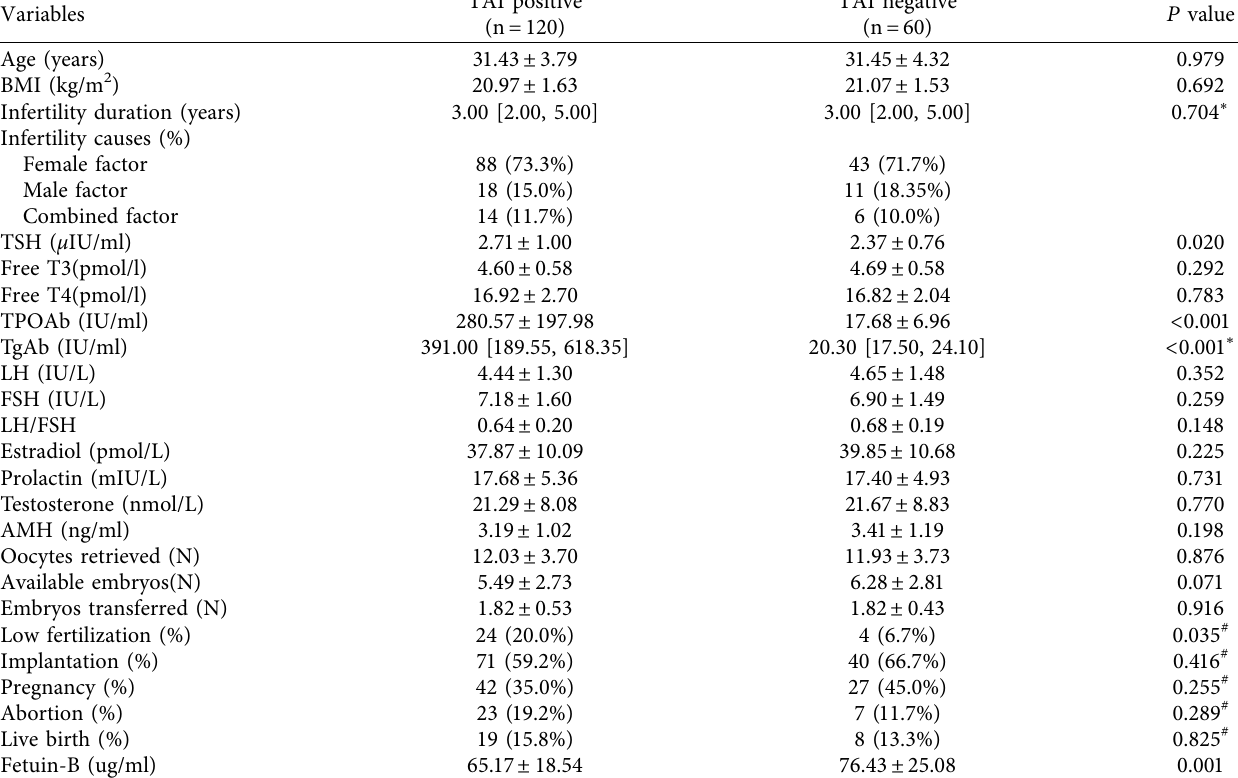
Table 1: Baseline characteristics of subjects according to the status of thyroid antibodies.